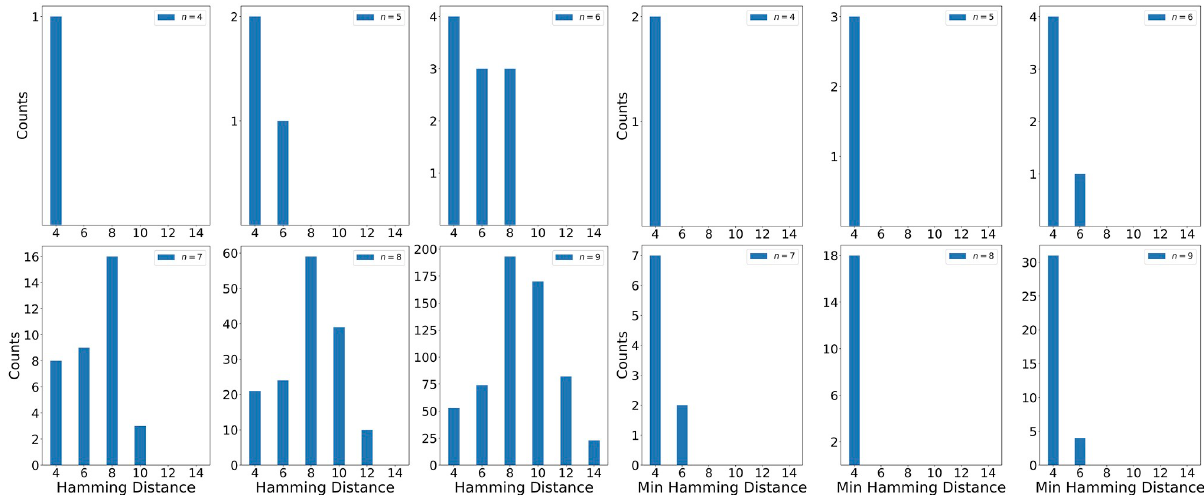
Fig 5. Measures of Hamming distances. Left: All pairwise Hamming distances, Right: Minimum Hamming distance to each isomer.